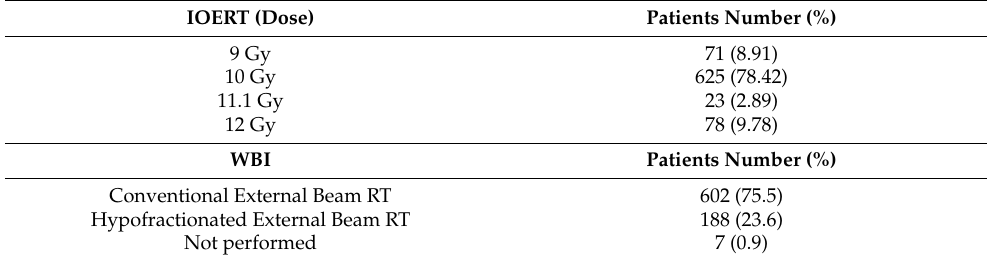
Table 3. Intra-Operative Electron Radiation Therapy (IOERT) and Whole Breast Irradiation (WBI) doses and patient